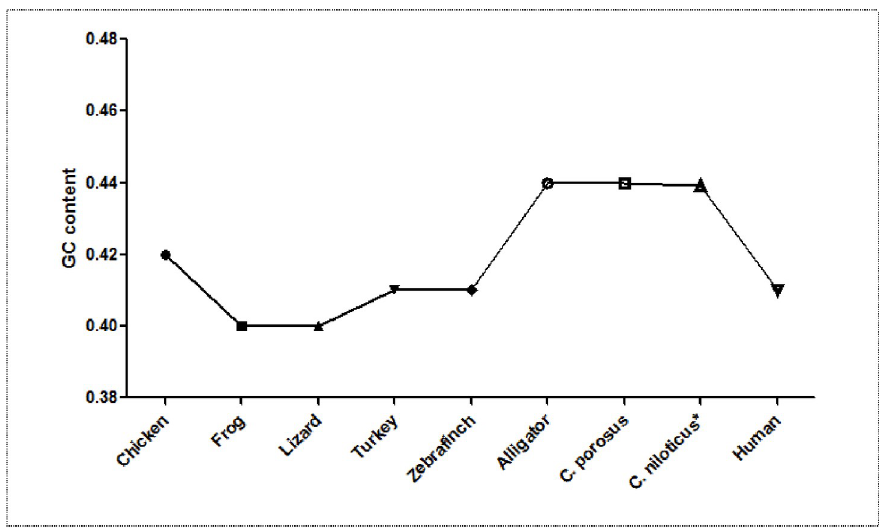
Fig 1. Comparison of GC contents of the transcriptomes from selected vertebrates including humans. Note that Alligators and crocodiles have similar and highest GC content [5], http://genomebiology.com/2012/13/1/415.